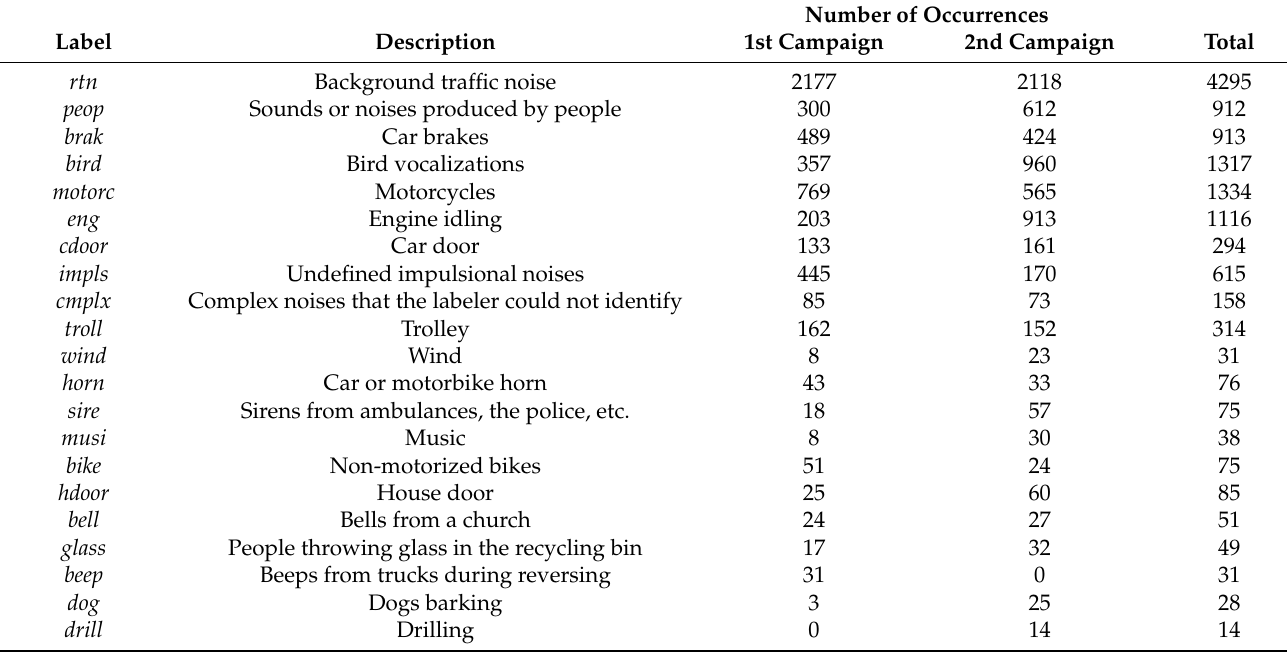
Table 1. Number of events annotated on the dataset.